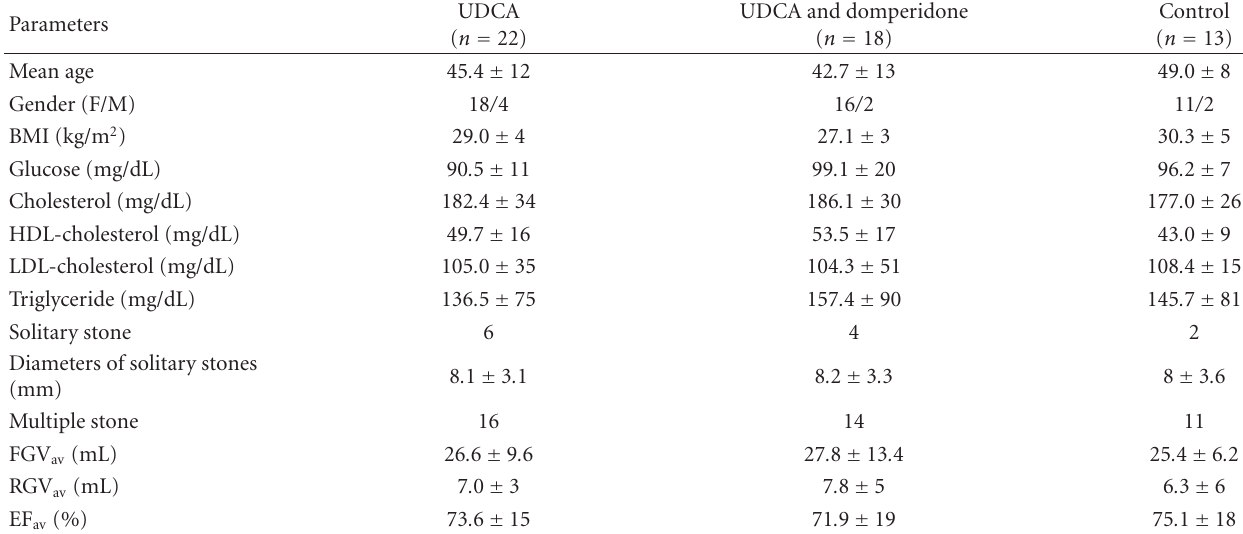
Table 1: Demographic and clinic characteristics of groups before the treatment ∗ .